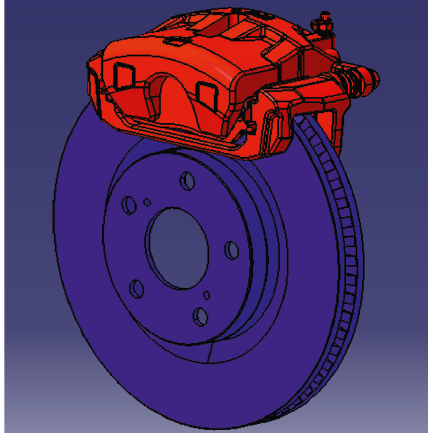
Figure 1: 3D model assembly drawing of the ventilated disc Table 1: The basic dimensions of the friction pair.